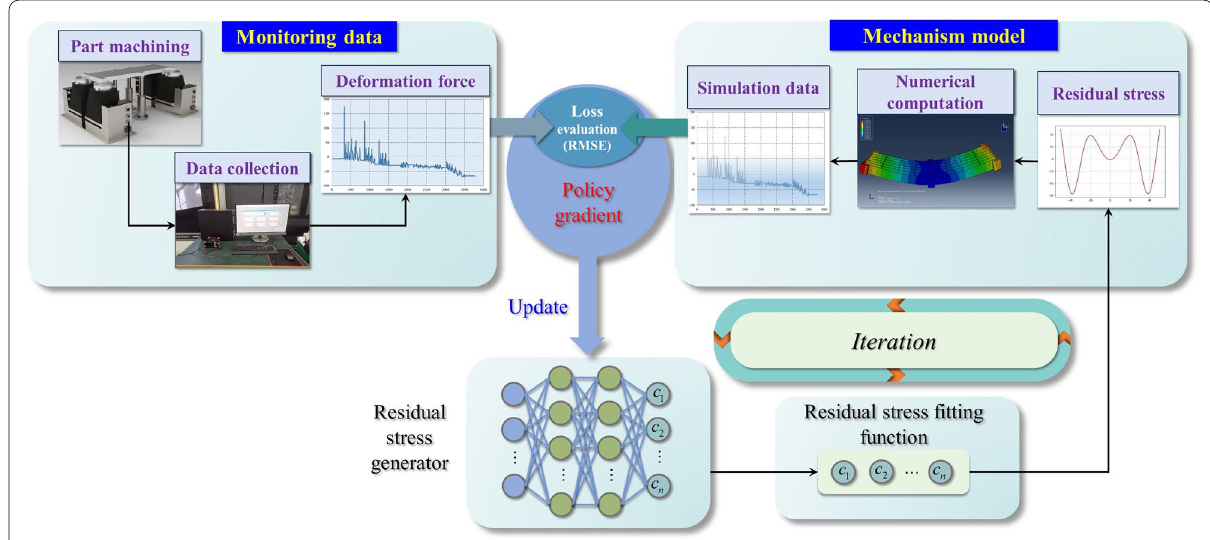
Figure 1 General idea of the proposed inference method of initial residual